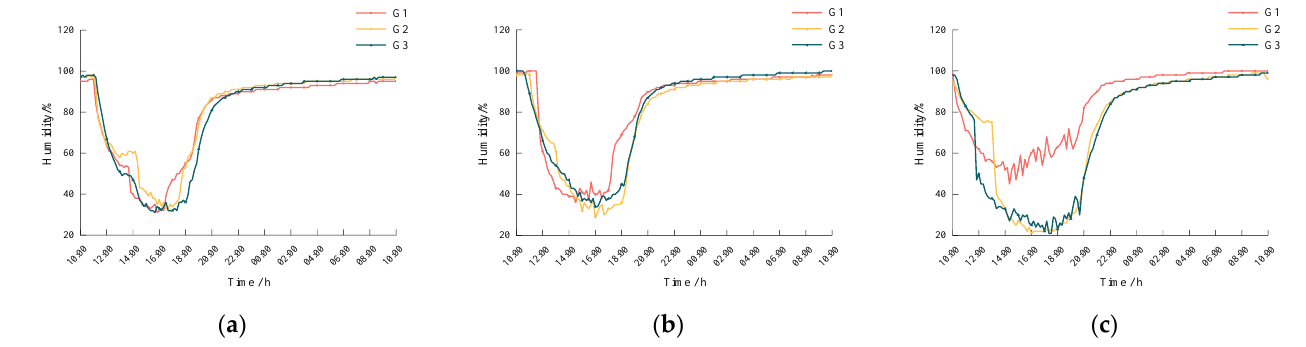
Figure 7. Humidity variation of CSGs on typical sunny days from January to March. ( a ) 28 January 2022. ( b ) 20 February 2022. ( c ) 31 March 2022.